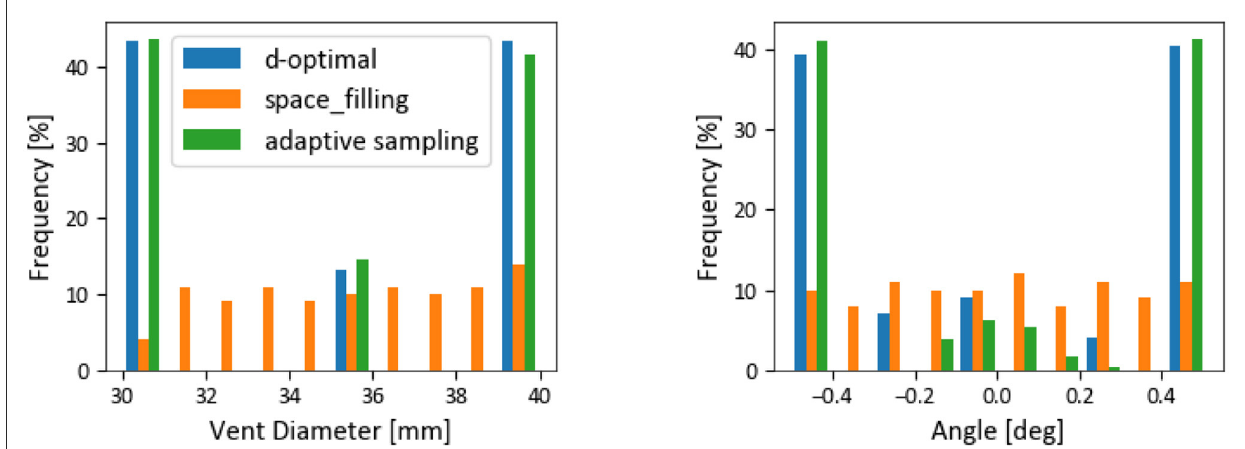
FIGURE9 Distribution of vent diameter and impact angle for different sampling